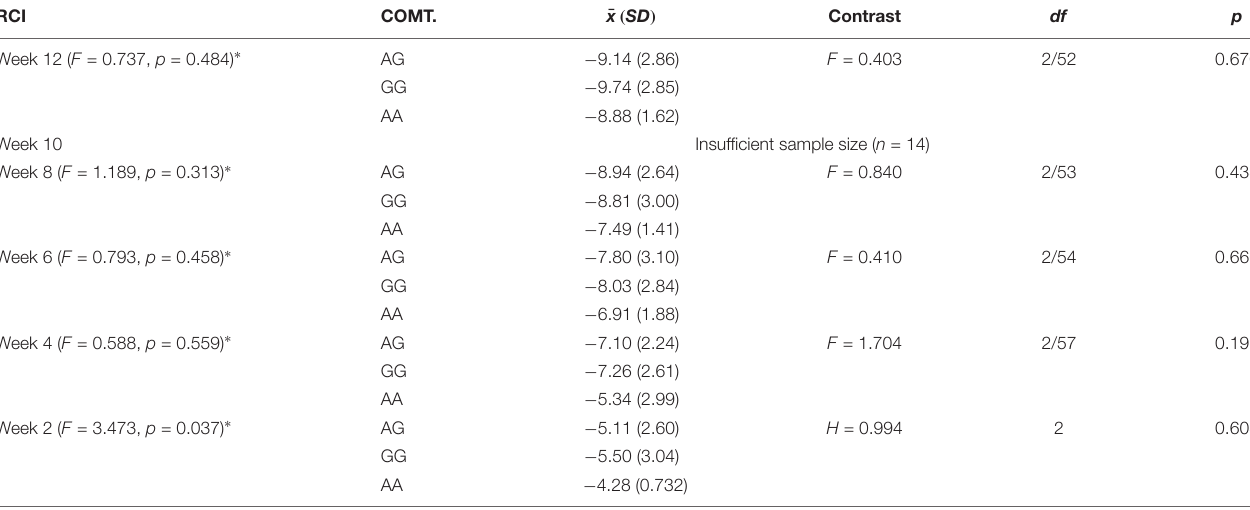
TABLE 7 | Mean, SD, bivariate analysis (ANOVA/ Kruskall Wallis test ), and homogeneity test of the RCI in all the weeks and the variable COMT. RCI COMT. ¯ x ( SD ) Contrast df p Week 12 ( F = 0.737, p = 0.484) ∗